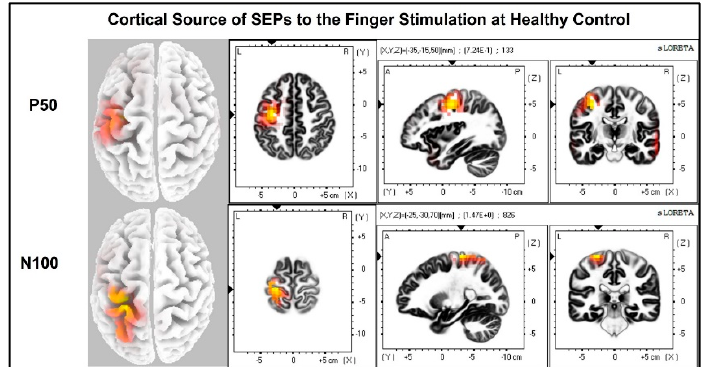
Figure 7. Laterality Index. Stars indicate statistically significant differences among control, stroke paretic hand (Stroke-P), and stroke non-paretic hand (Stroke-N): * < 0.05.